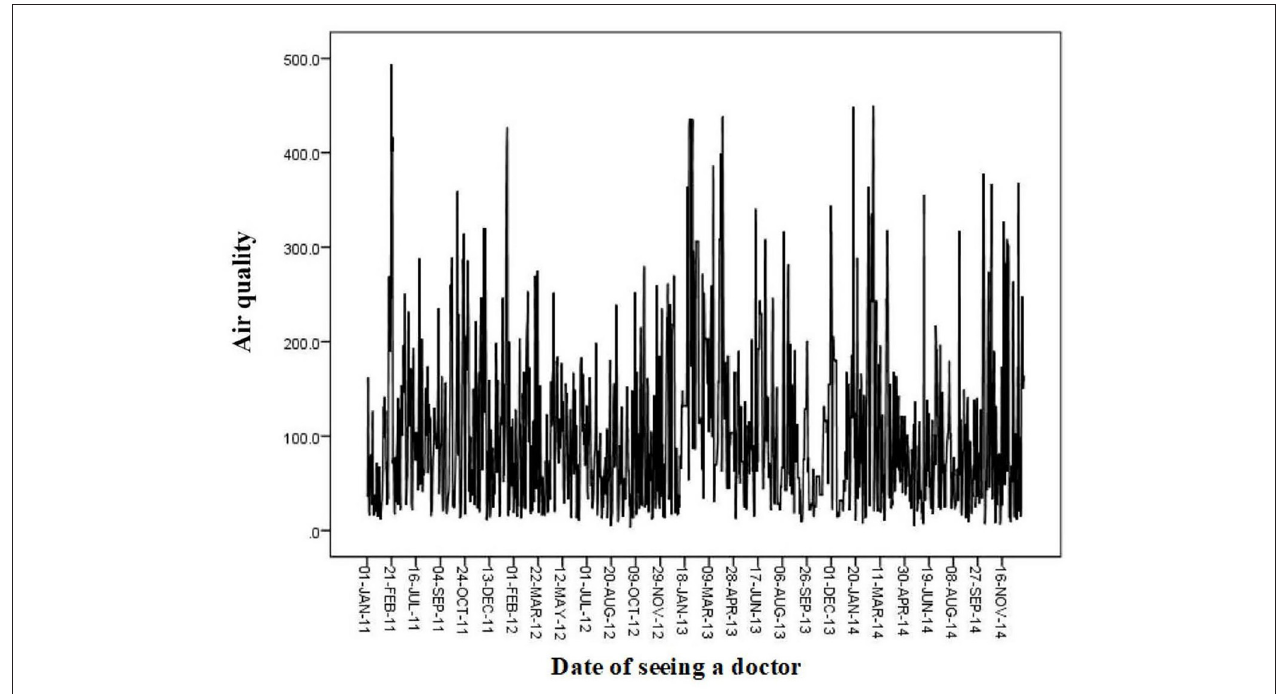
FIGURE 1 | Daily air quality,